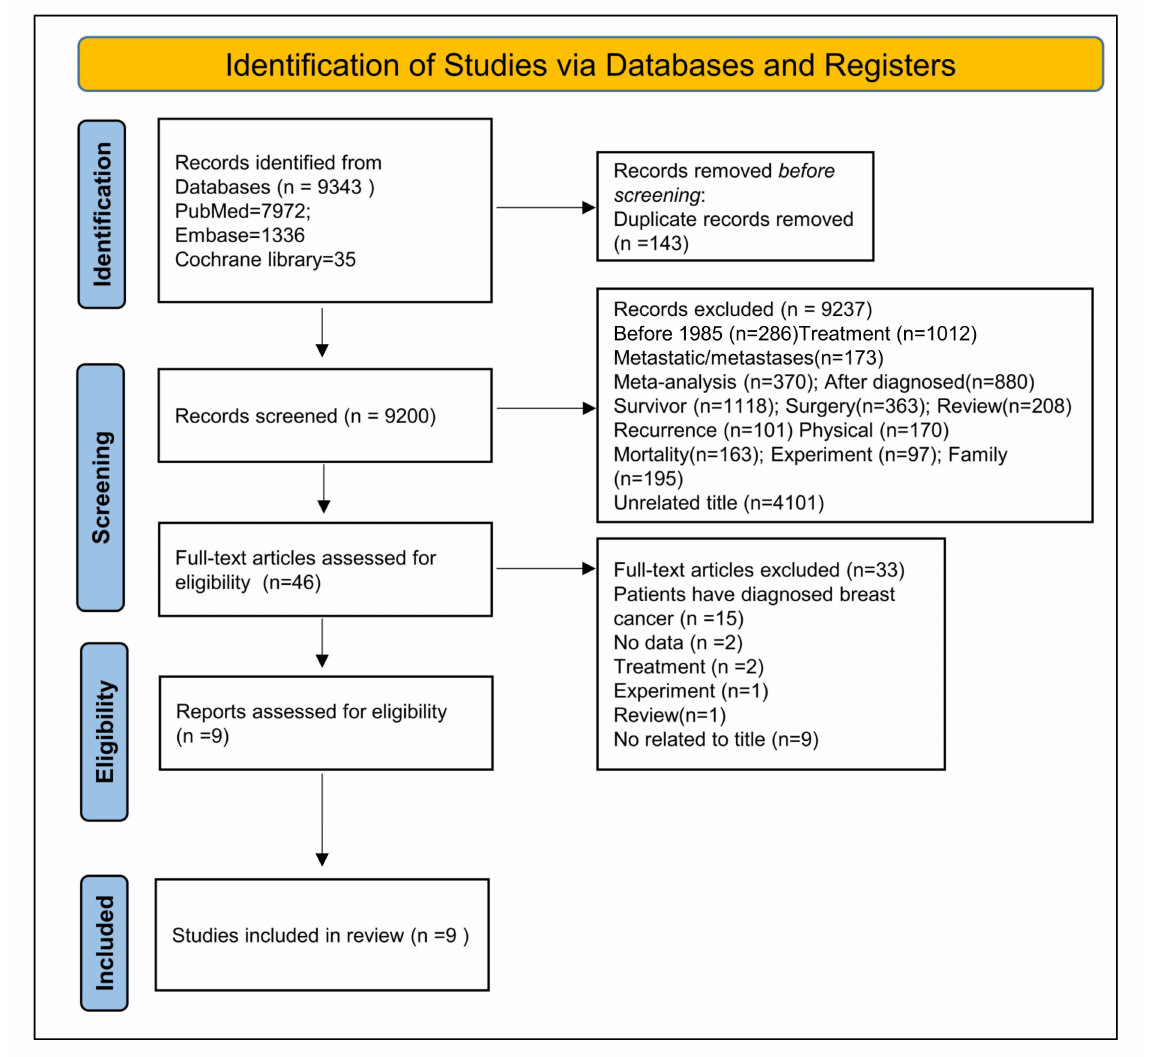
Figure 1. Selection of studies for inclusion in the meta-analysis based on PRISMA